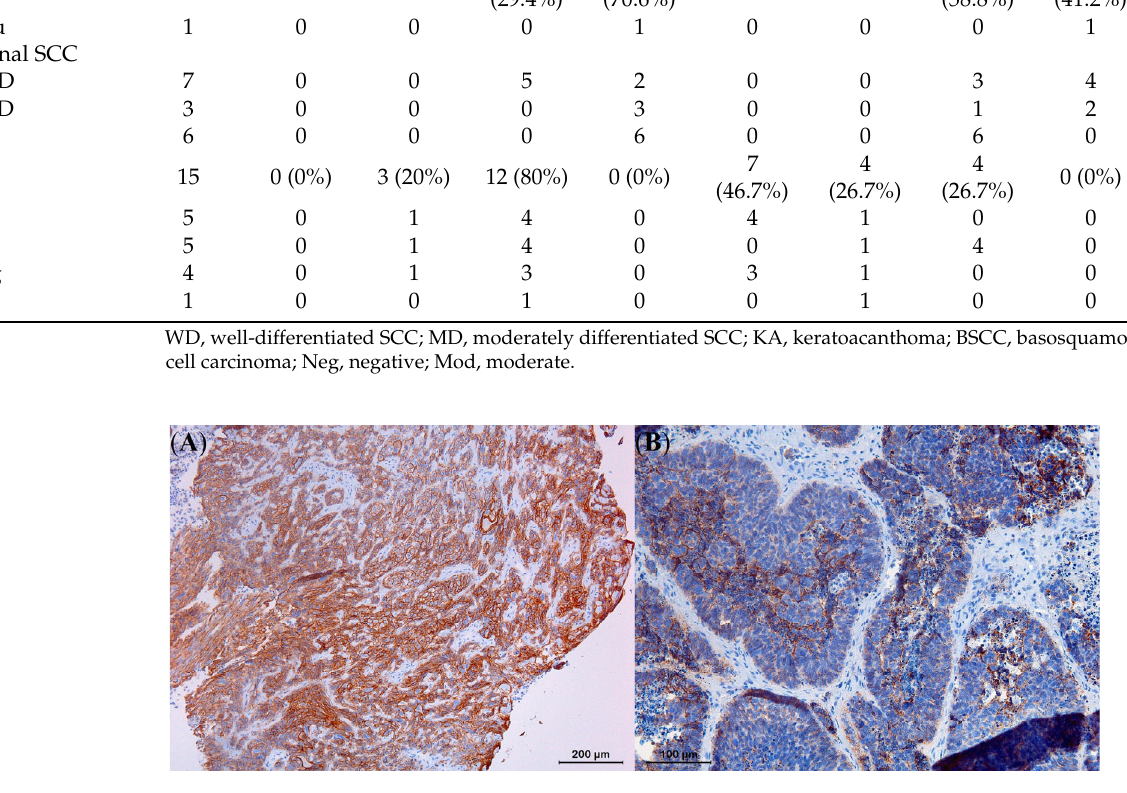
Figure 10. Di ff use and strongly positive intracytoplasmic cyclooxygenase-2 expression could be noted in a well-di ff erentiated squamous cell carcinoma ( A ) in contrast to negative cyclooxygenase- 2 expression in a solid basal cell carcinoma ( B ). All SCCs and BCCs described in this study showed strong pan-CK reactivity, which allowed sharp delineation of the neoplastic processes from the surrounding tissue and assessment of the integrity of the basement membrane. Immunohistochemical analysis utilizing antisera against epithelial antigen clone Ber- EP4 and EMA did not demonstrate positive staining in either the tumor cells or the control skin tissues from reptiles. Nonetheless, positive controls consisting of mammary gland tissue from dogs showed positive immunoperoxidase labelling for epithelial antigen clone Ber-EP4 and EMA.